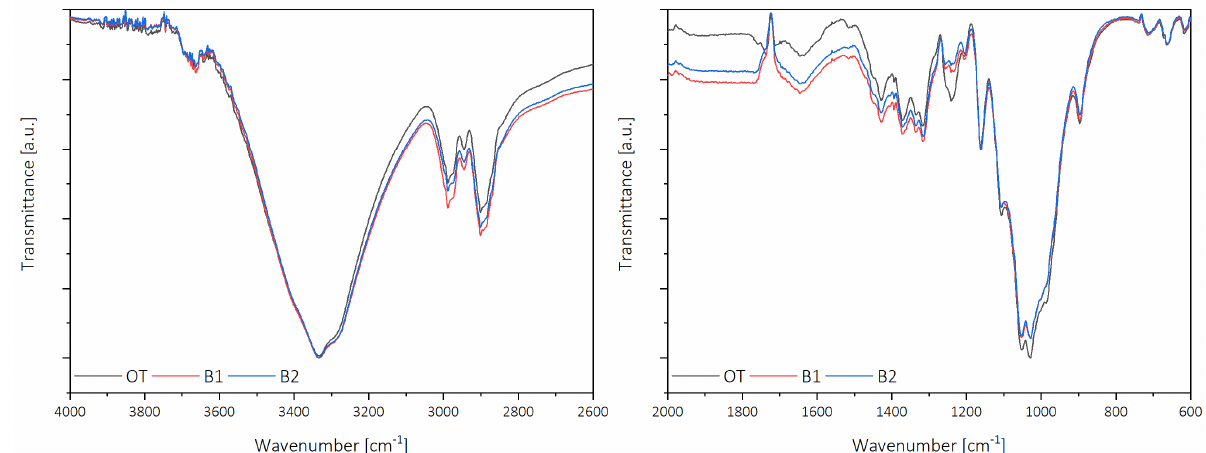
Figure 2. Infrared spectra of the different nanofibers.